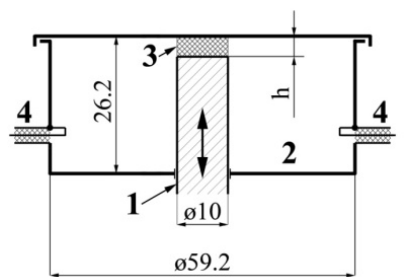
Figure 16. The scheme of a tunable coaxial resonator with an end capacitive gap.